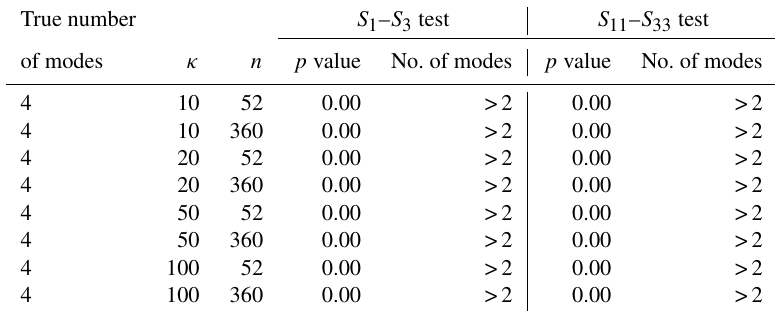
Table 2. The p values and corresponding decisions at the 5% significance level of randomisation tests of bimodality for quadrimodal equal mixtures of Watson distributions; n is the total sample size and B = 999 further randomisation samples per dataset (see text for